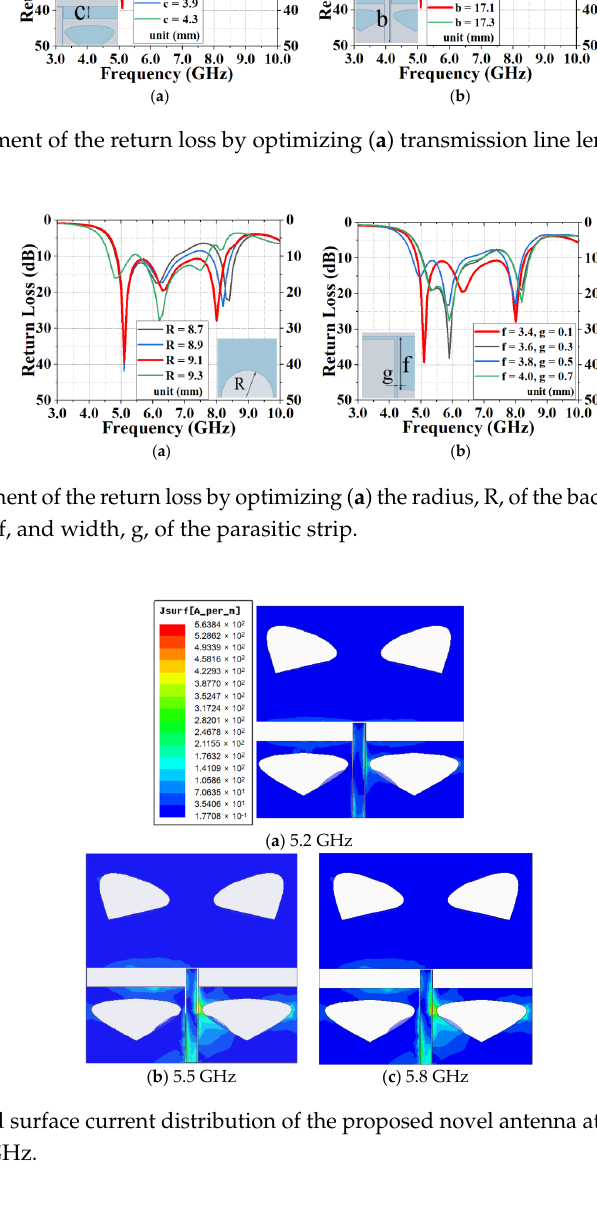
Figure 9. Simulated surface current distribution of the proposed novel antenna at frequencies of 5.2 ( a ), 5.5 ( b ) and 5.8 ( c ) GHz. 5.5 ( b ) and 5.8 ( c )